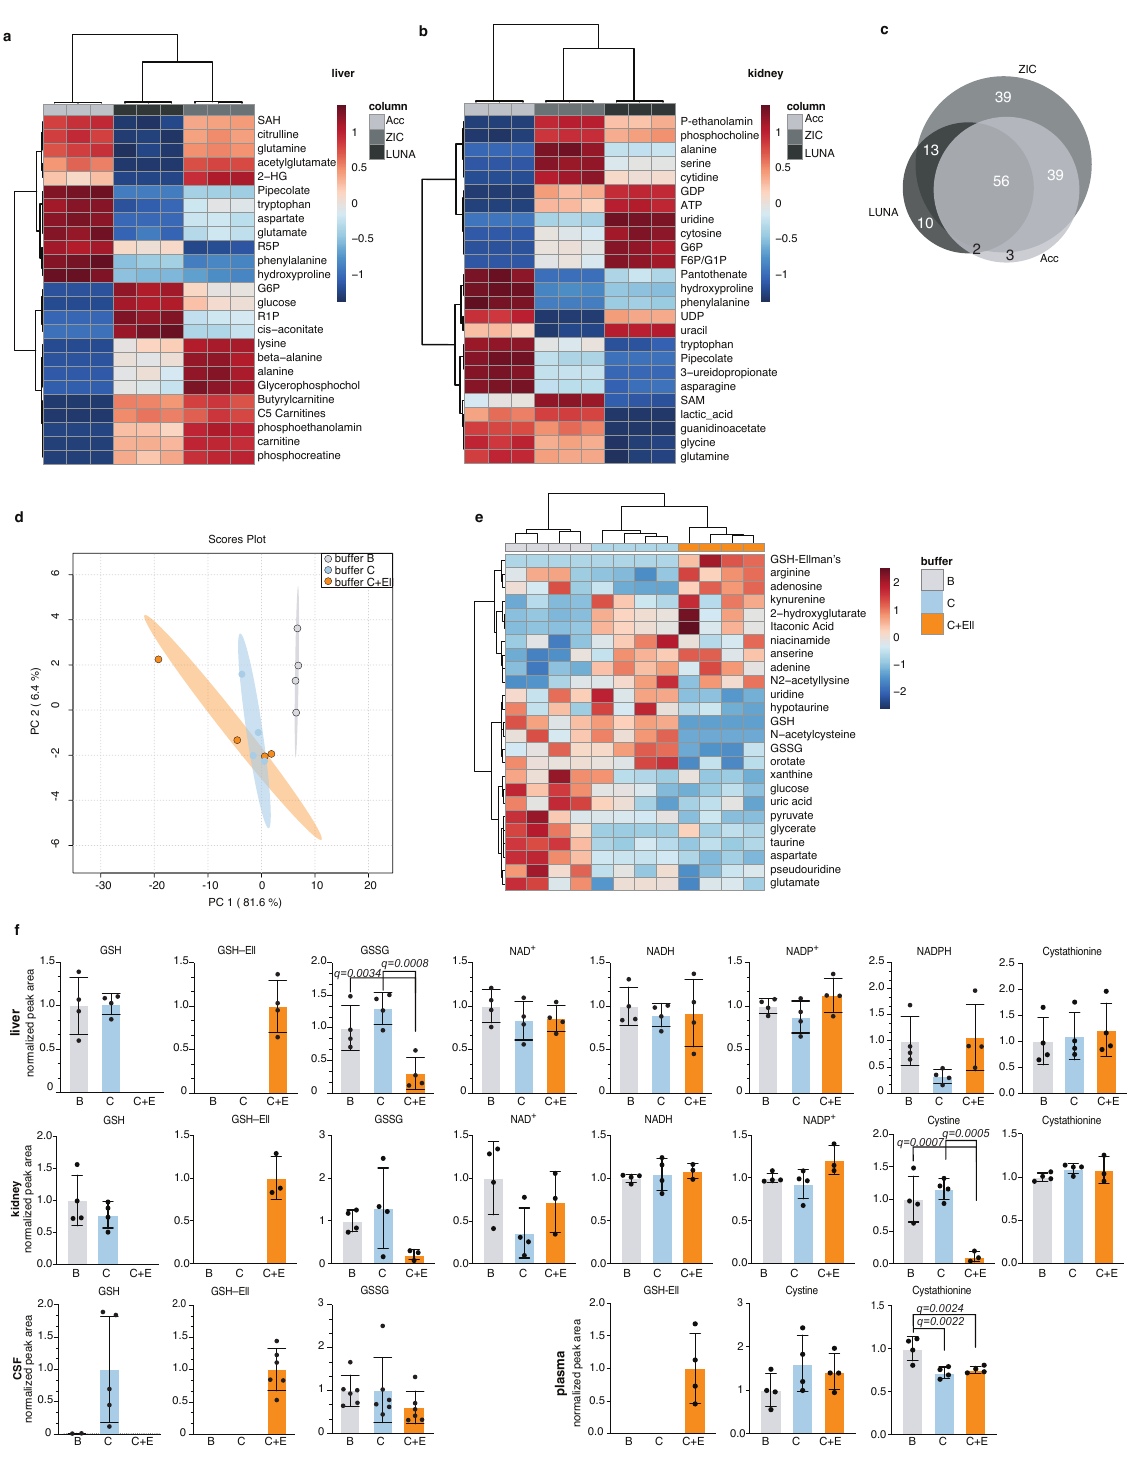
Figure 3. Application of the redox metabolite detection method for mammalian tissues; ( a , b ) Top 25 differentially detected metabolites between three chromatographic methods in mouse liver ( a ) and kidney ( b ) presented in a heatmap for each organ. Each replicate is a tissue chunk from an independent mouse, extracted in buffer C+Ell and then split in three and run on the different chromatographies. ZIC: ZIC-pHILIC, Acc: Accucore-NH2, LUNA: LUNA-NH2; ( c ) Venn diagram of total detected metabolites in liver and kidney between the three chromatographic methods from ( a , b ) and the overlap between them. Only metabolites passing 30% CV cutoff were compared; ( d ) Global PCA analysis of polar metabolites detection in mouse liver samples extracted by three different buffers (B, C, C plus Ellman’s) and detected by LC-MS using the ZIC-pHILIC column; Each replicate represents a liver chunk from an independent mouse, subdivided evenly